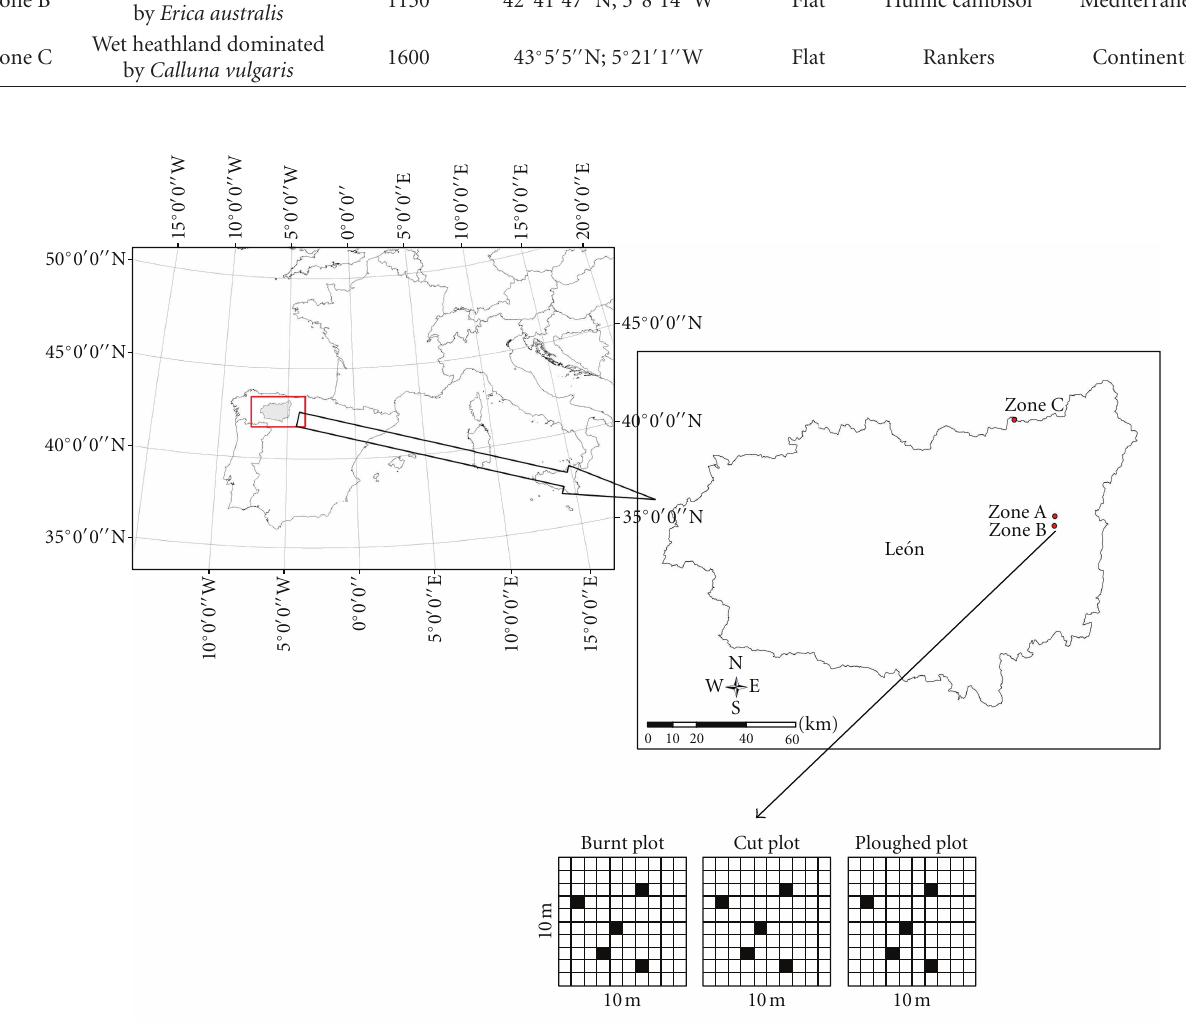
Figure 1: Location of the experimental study zones. Structure of the sampling